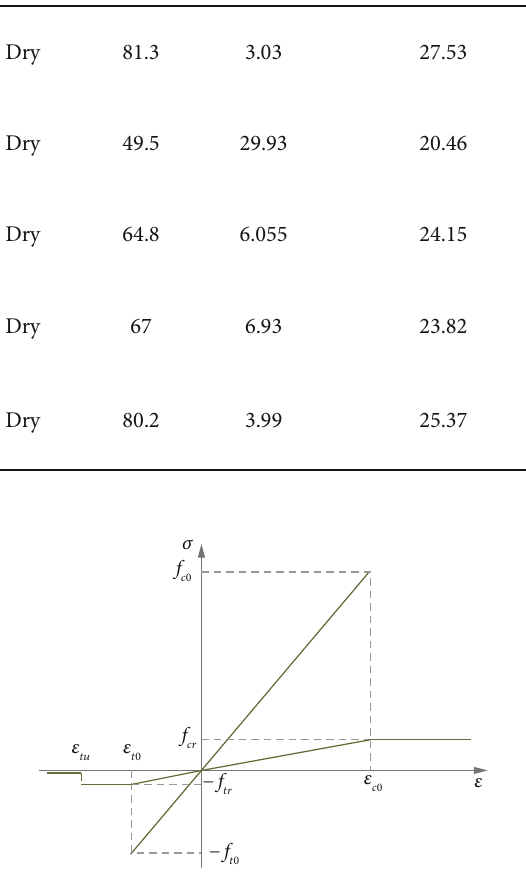
Figure 8: Elemental damage constitutive relation.